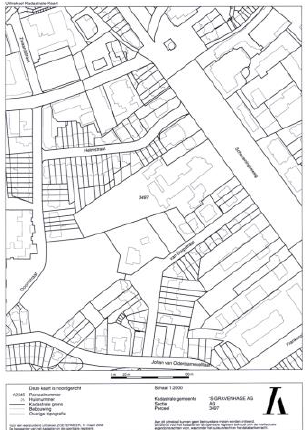
Figure 1: Cadastral map with verified